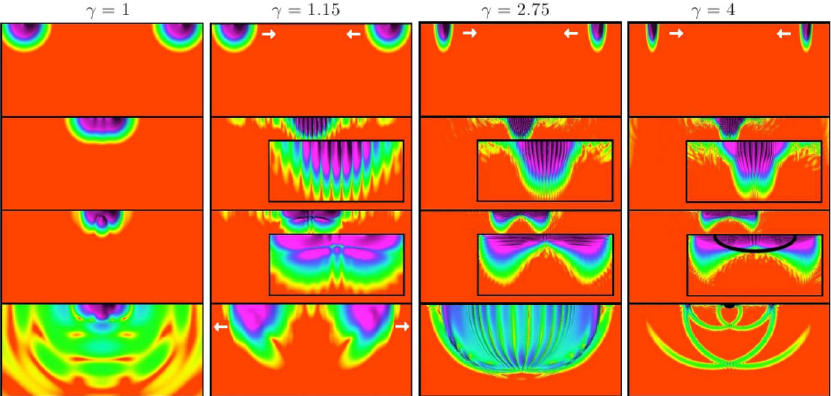
Fig. 35 Evolutions of the head-on collisions of identical boson stars boosted toward each other with initial Lorentz factors c as indicated. Time fl ows downward within each column and the top edge displays the axis of symmetry. The color-scale indicates the value of j / j . In the middle frames one sees the interference pattern characteristic of high kinetic energy BS collisions (as mentioned in Fig. 1). In the last column on the right, the collision produces a BH with apparent horizon indicated by the black oval in the third frame. Reproduced with permission from Choptuik and Pretorius (2010), copyright by